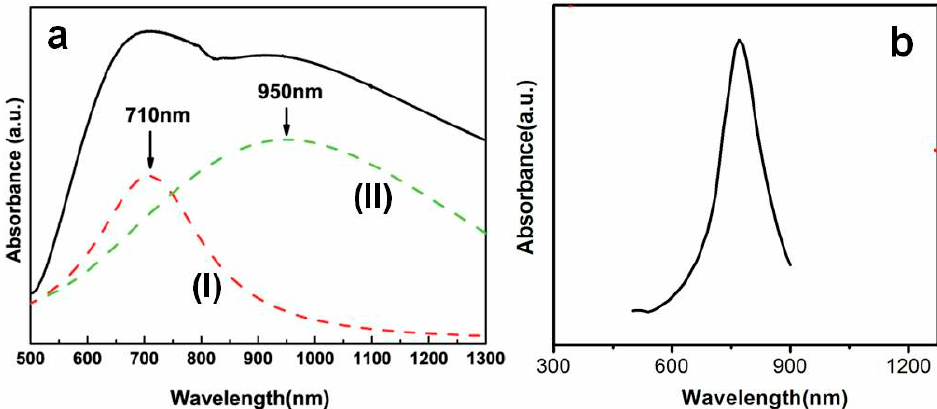
Figure 11. Optical absorbance spectra of the gold binary-structured array shown in Figure 10a. ( a ): The measured absorbance spectrum. Dash lines (I) and (II) are the results of spectral decomposition by Gaussian peak-type. ( b ): The absorption spectrum of a standing nanoring simulated by DDA (Guangqiang Liu et al. [29]).